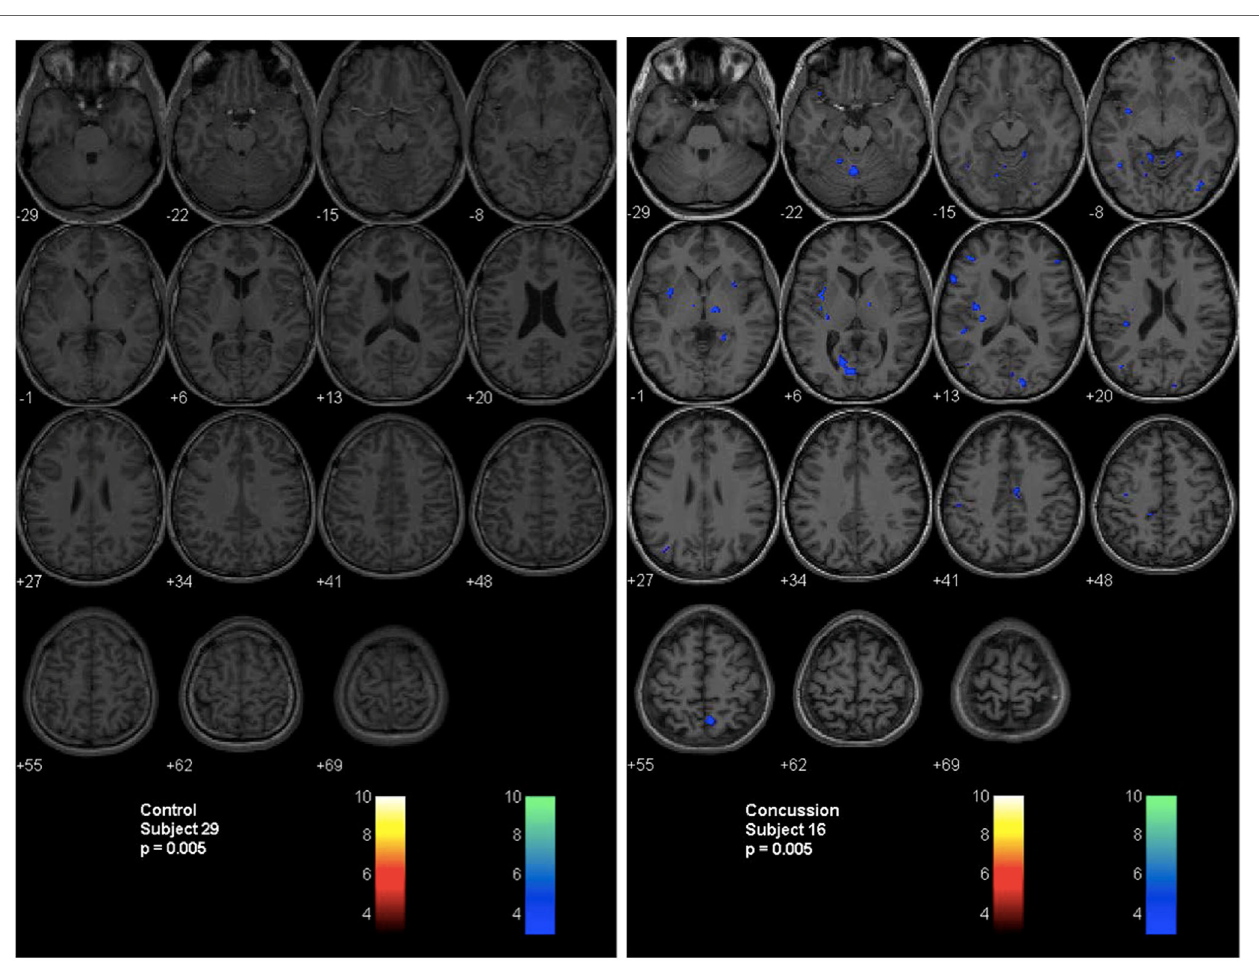
FiGUre 4 | second-level analysis maps and postconcussion symptom scale scores for healthy control subject and adolescent postconcussion syndrome patient . Second level individual comparisons examined at the p = 0.005 level demonstrate no evidence of abnormal voxels in the healthy control subject compared to the atlas of normal controls (left panel). Quantitative patient-specific alterations in cerebrovascular responsiveness are demonstrated in the adolescent postconcussion syndrome patient (right